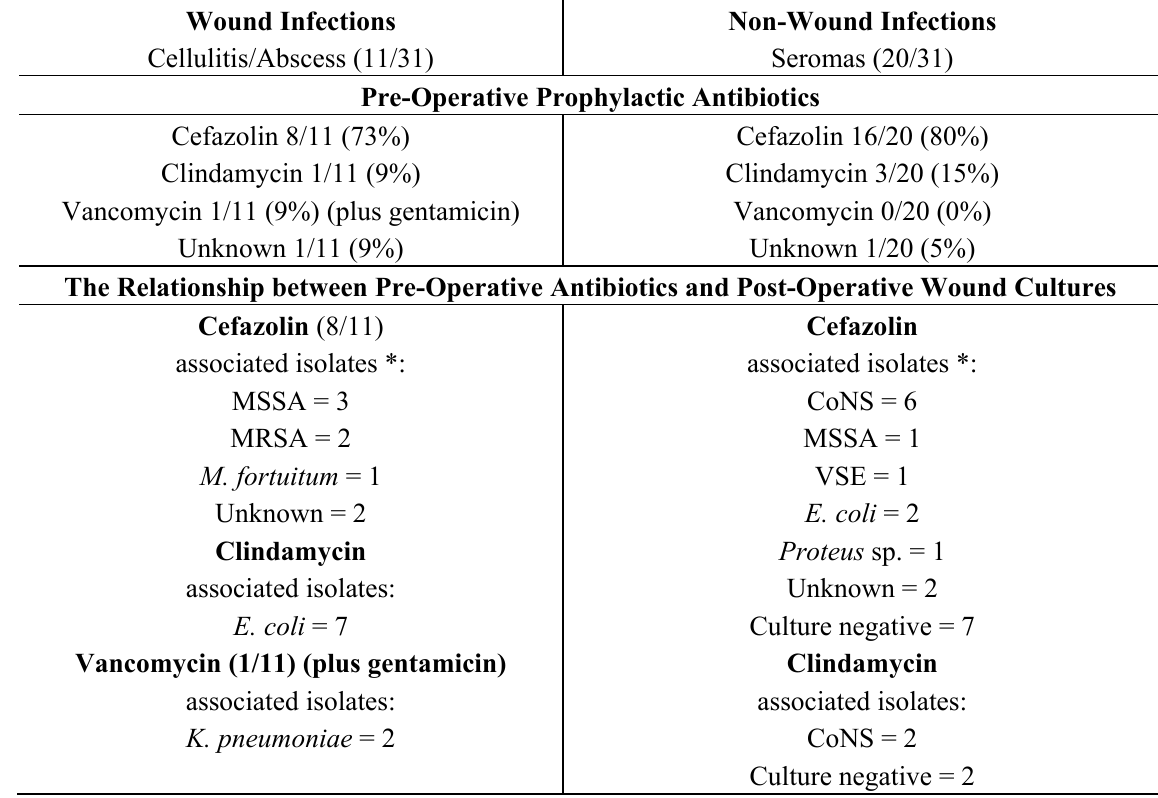
Table 2. Potential post-laminectomy wound infections (2010–2012).